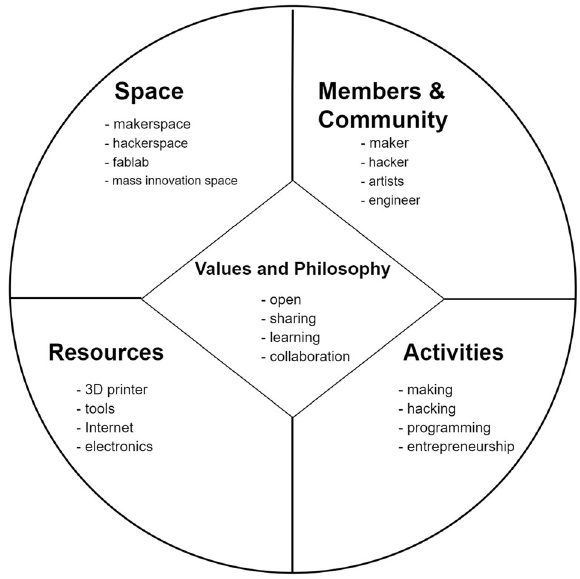
Fig. 1 Key elements of the makerspace. This fi gure shows the fi ve key elements of the makerspace: space, members and community, resources, activities, values and